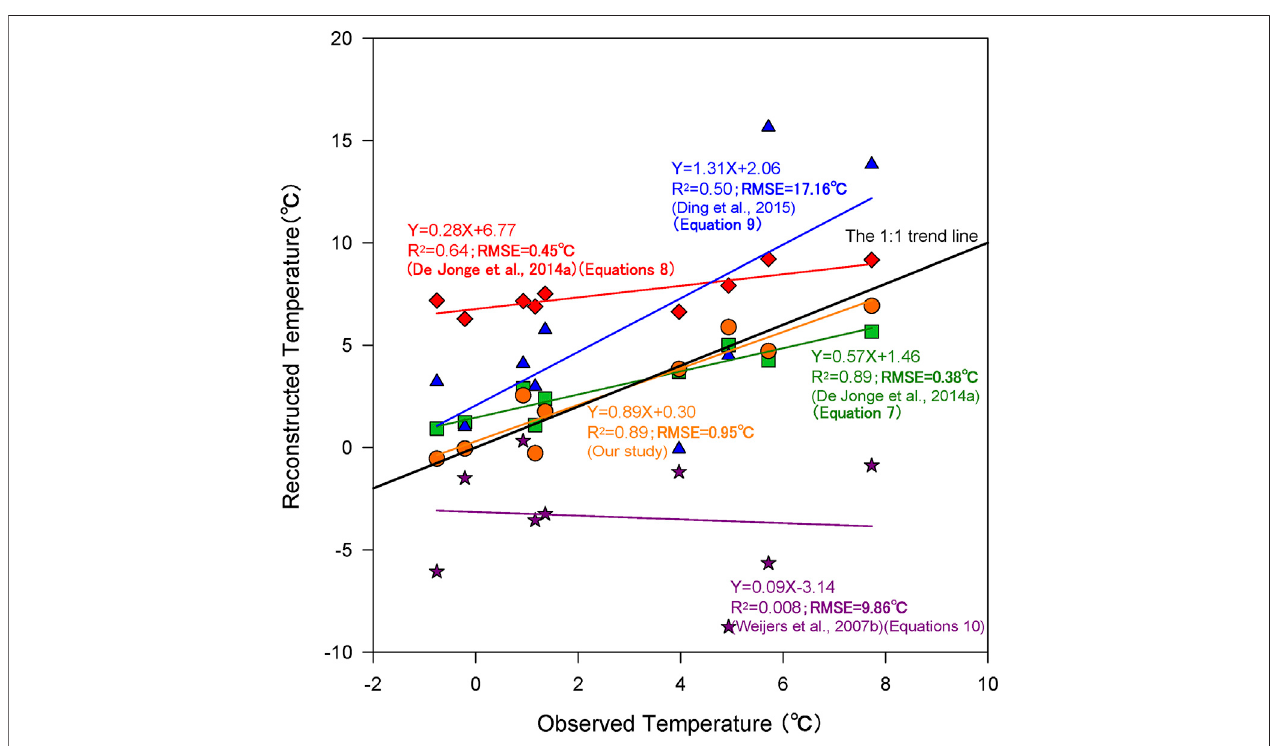
FIGURE 6 | Correlation between reconstructed temperature and observed temperature.